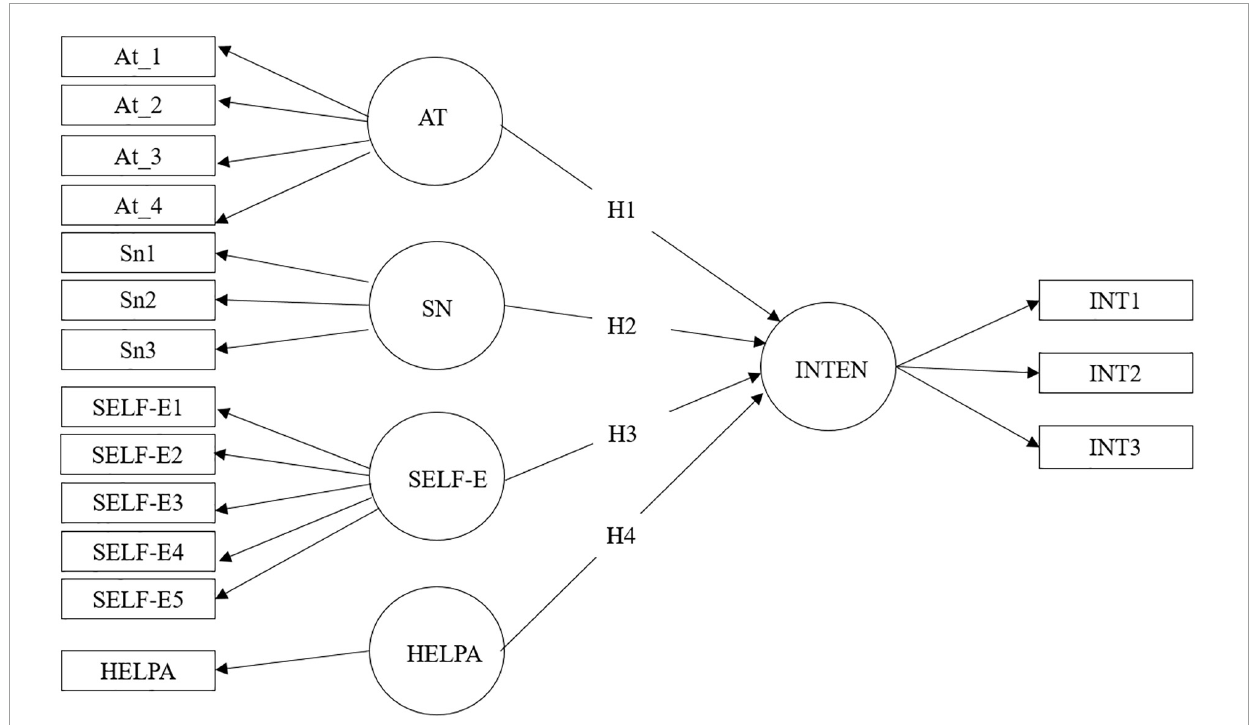
FIGURE1 Theoretical model and hypothesis. At_1 = attitude 1 [(item 1 × item 5)/5], At_2 = attitude 2 [(item 2 × item 6)/5], At_3 = attitude 3 [(item 3 × item 7)/5], At_4 = attitude 4 [(item4 × item8)/5]; SN1 = subjective norm 1 [(item 1 × item 4)/5], SN2 = subjective norm 2 [(item 2 × item 5)/5], SN3 = subjective norm 3 [(item 3 × item 6)/5]; AT, attitude; SN, subjective norm; SELF-E, self-efficacy; HELPA, help-seeking in the past; INT,